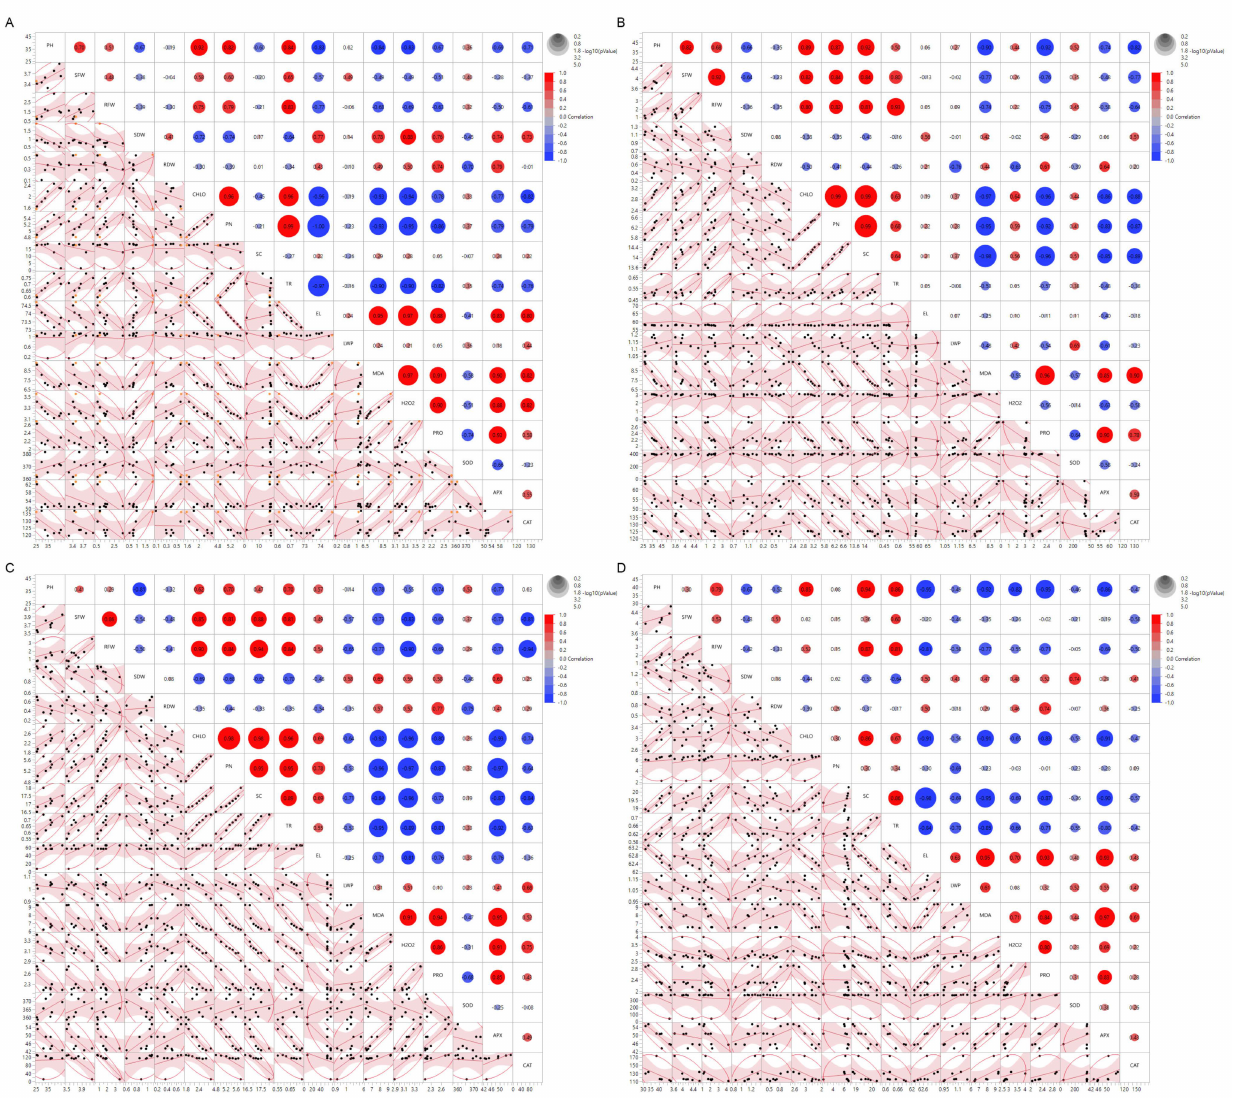
Figure 4. Scatter plot and heatmap correlation matrix of different morpho-physiological parameters for eight genotypes grown under ( A ) drought stress and ( B ) drought + SeNPs, ( C ) heat stress, and ( D ) heat + SeNPs. Abbreviations: Plant Height (PH), Shoot Fresh Weight (SFW), Shoot Dry Weight (SDW), Root Fresh Weight (RFW), Root Dry Weight (RDW), Total Chlorophyll (CHLO), Net Photo- synthetic Rate (PN), Stomatal Conductance (SC), Transpiration Rate (TR), Electrolyte Leakage (EL), Leaf Water Potential (LWP), Malondialdehyde (MDA), Hydrogen Peroxide (H 2 O 2 ), Proline (PRO), Superoxide Dismutase (SOD), Ascorbate Peroxidase (APX), and Catalase